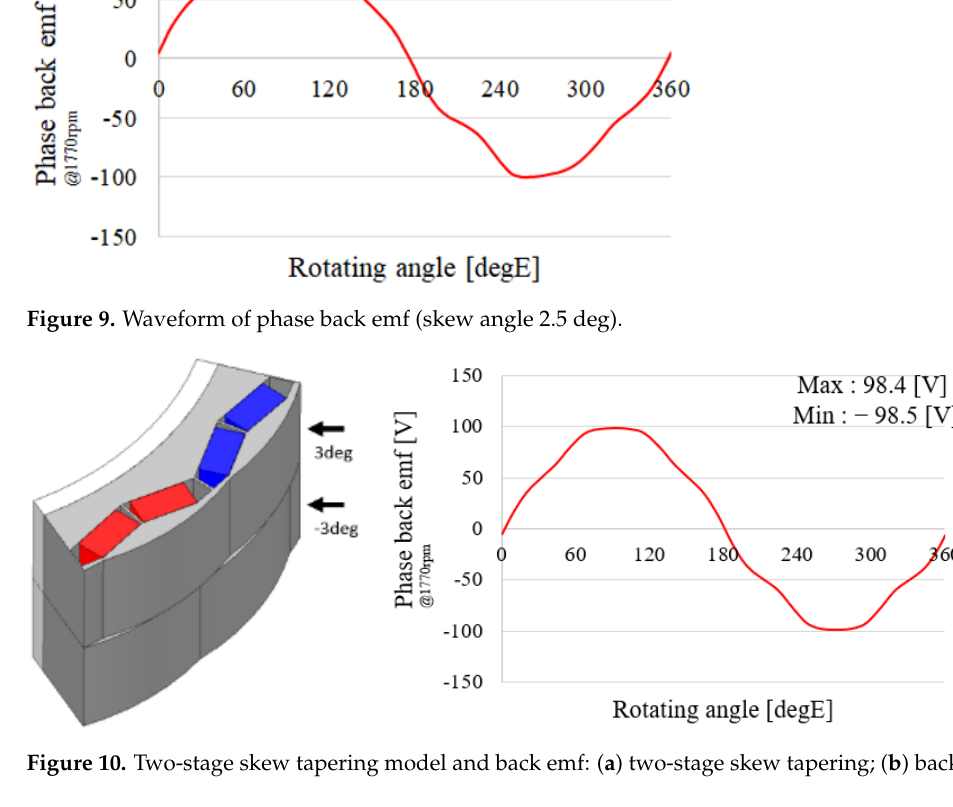
Figure 9. Waveform of phase back emf (skew angle 2.5 deg).